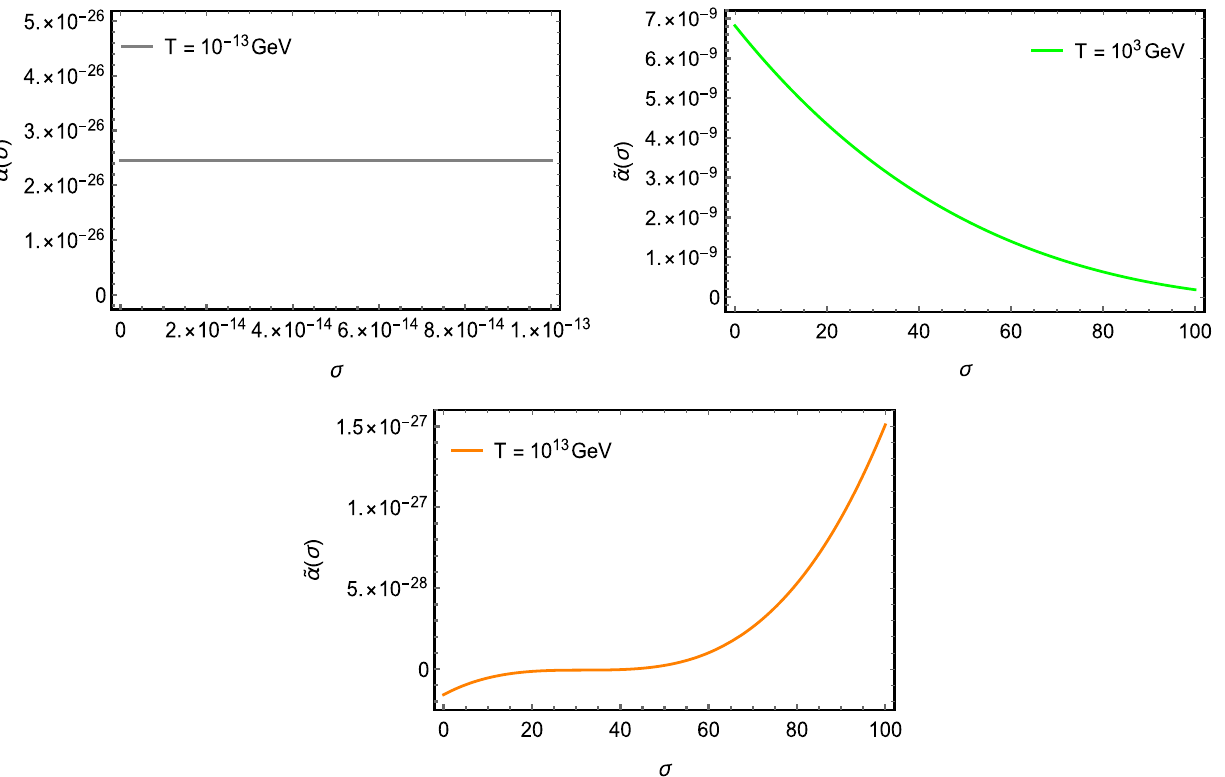
Fig. 2 The figure shows the correction to the Stefan–Boltzmann law ascribed to parameter ˜ α as a function of σ (its unit is GeV − 1 ) for